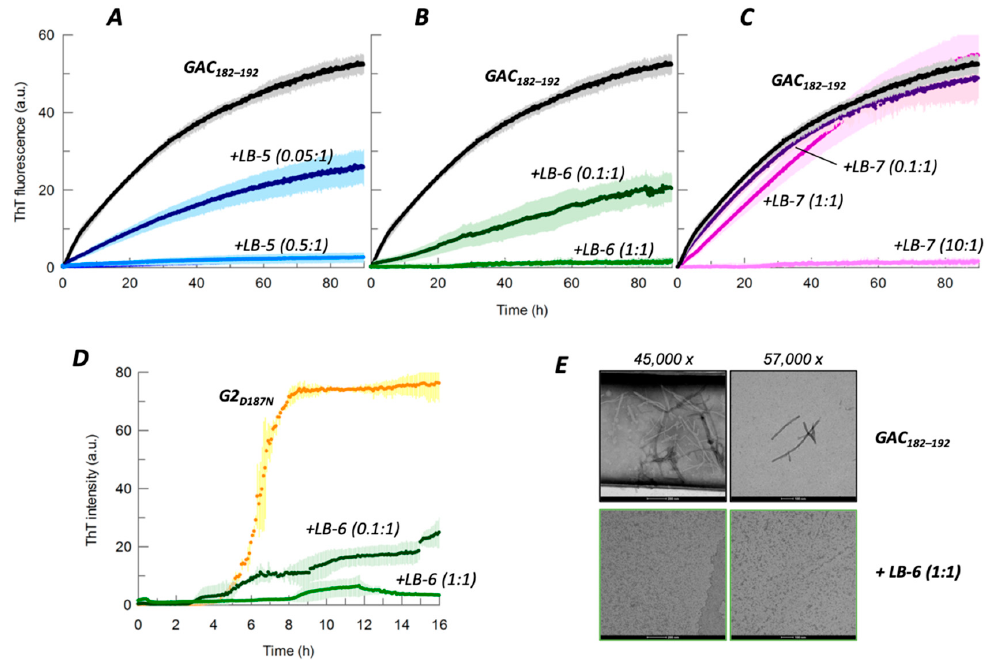
Figure 2. Inhibitory activity of peptidomimetics. ( A – C ) Representative curves of ThT fluorescence assays showing GAC 182–192 (100 µM) aggregation over time in the absence (black curve) and presence of increasing concentrations of LB-5 (5–50 µM, blue trace), LB-6 (10–100 µM, green), or LB-7 (10–1000 µM, purple). Data are the mean ± SD (bars of a lighter shade of data colour) of three replicates. ( D ) Under the same conditions, the ability of LB-6 (7.5–75 µM) to inhibit aggregation of 75 µM isolated G2 carrying the D187N mutation (G2 D187N ) was evaluated. ( E ) Representative transmission electron microscopy images of 100 µM GAC 182–192 incubated for 96 h in the absence or presence of 100 µM LB-6 (1:1).